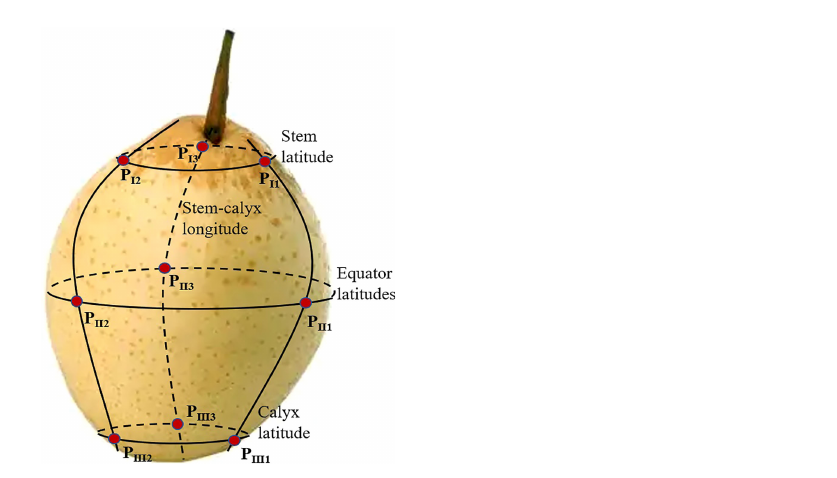
FIGURE 1 Diagram of the nine spectral measurement positions of one sample. The fi rst longitude intersects the stem latitudes, equator latitudes, and calyx latitudes form three spectral measurement positions: P I1 , P II1 , and P III1 . The second longitude and third longitude intersect to form six spectral measurement positions: P I2 , P II2 , and P III2 , and P I3 , P II;3 , and P III3 ,